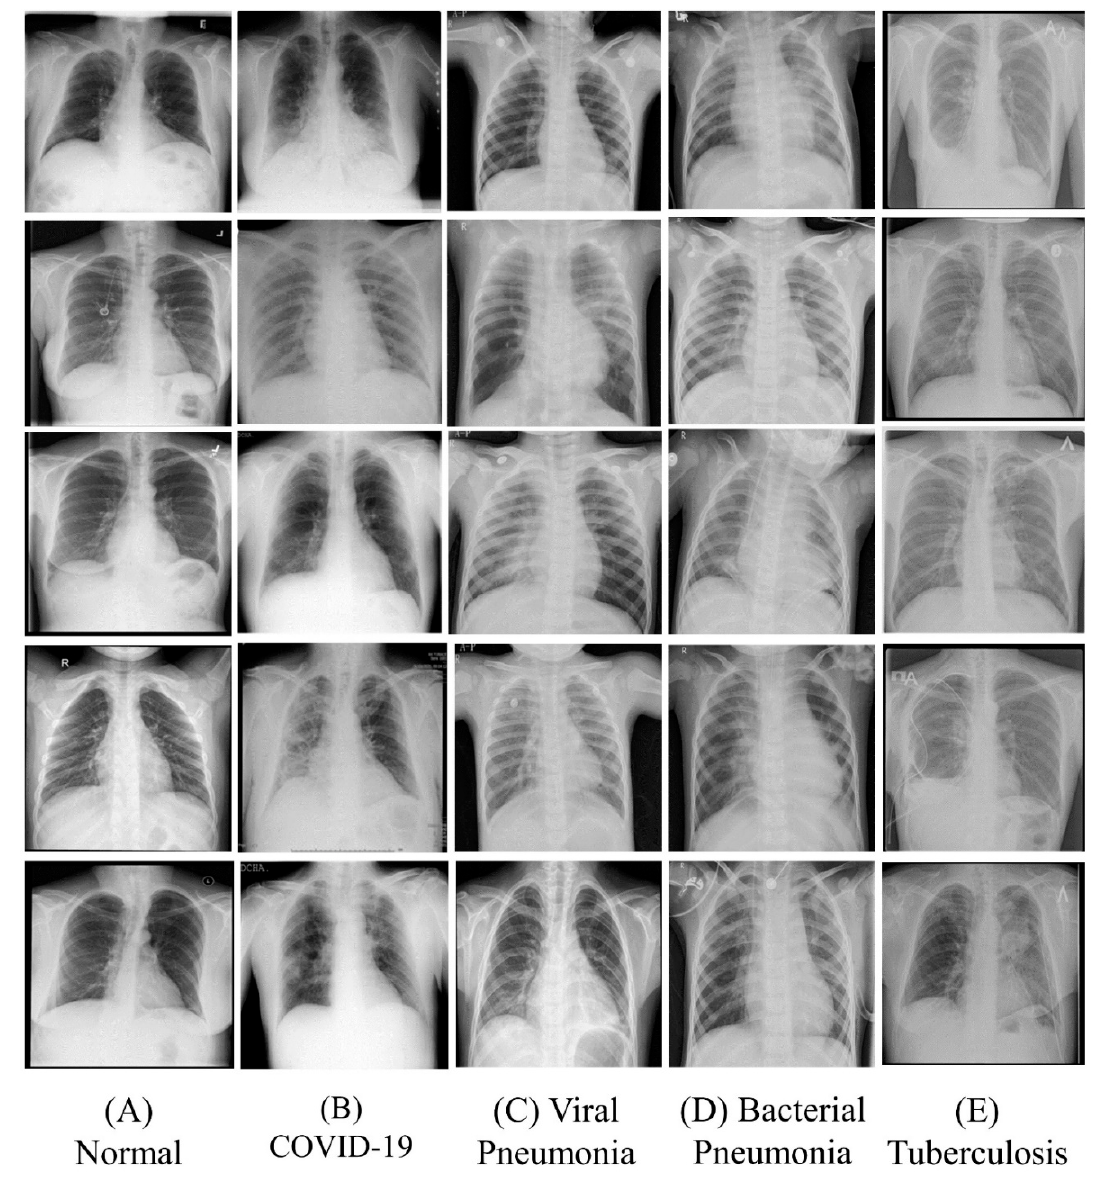
Figure 2. Sample chest X-ray images from each class.